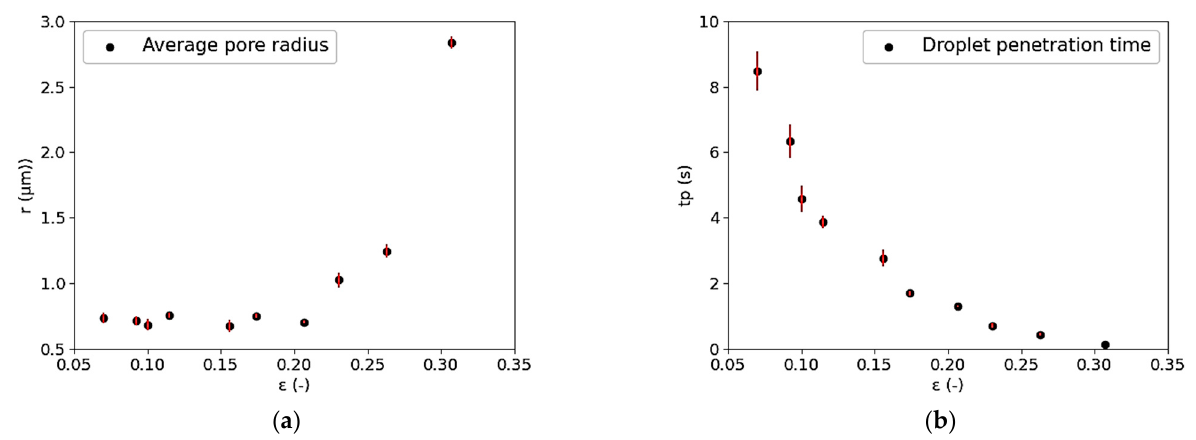
Figure 8. Variation of ( a ) the average pore radius and ( b ) the water droplet penetration time with the compressed MCC PH101 powder tablet average porosity.